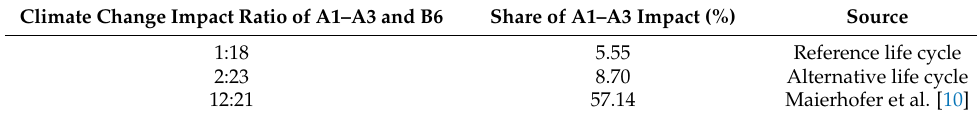
Table 5. Ratio comparison of climate change impact category based on m 2 GFA. Climate Change Impact Ratio of A1–A3 and